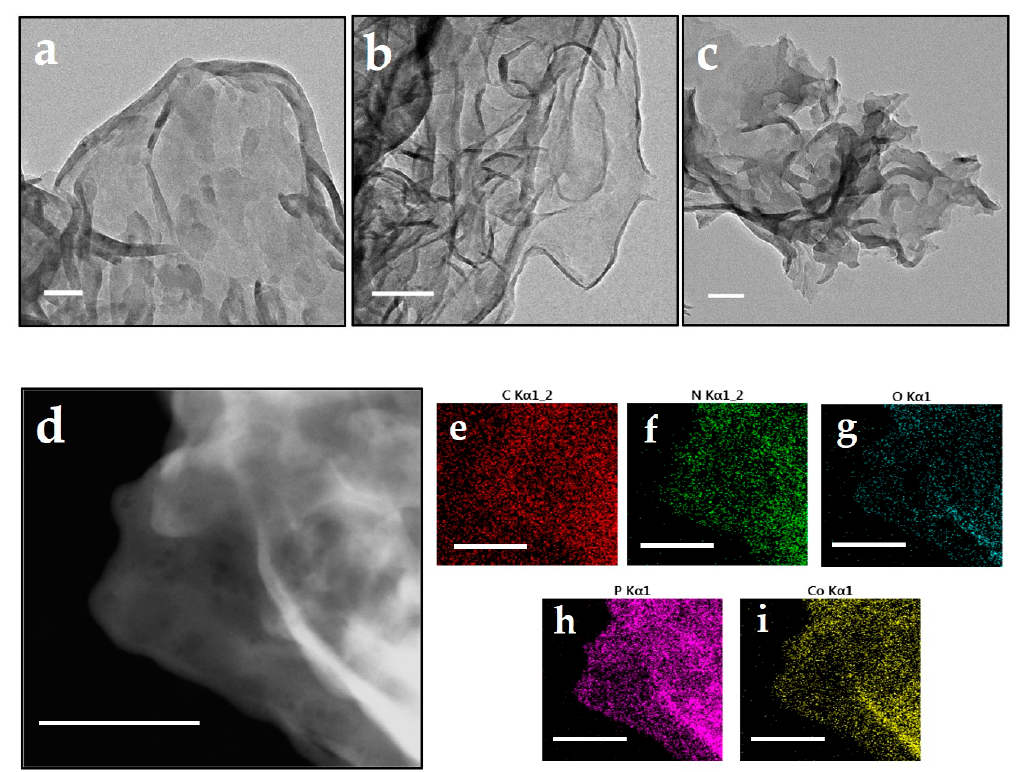
Figure 2. TEM images of ( a ) CN, ( b ) PCN, ( c ) Co@PCN (scale bar: 100 nm), and ( d – i ) scanning transmission electron microscope (STEM) images of Co@PCN and the EDX elemental mapping analysis (scale bar: 150 nm).